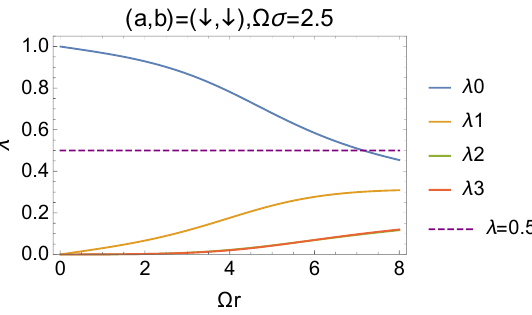
Figure 5. The behavior of the spectrum { λ µ } of the Bell diagonal state with fixed Ω σ = 2.5 and g 0 = 10 − 2 . The initial condition of the detectors’ state is |↓ A ↓ B (cid:105) . λ 0 is larger than the other eigenvalues, that is, the coherence | X | is